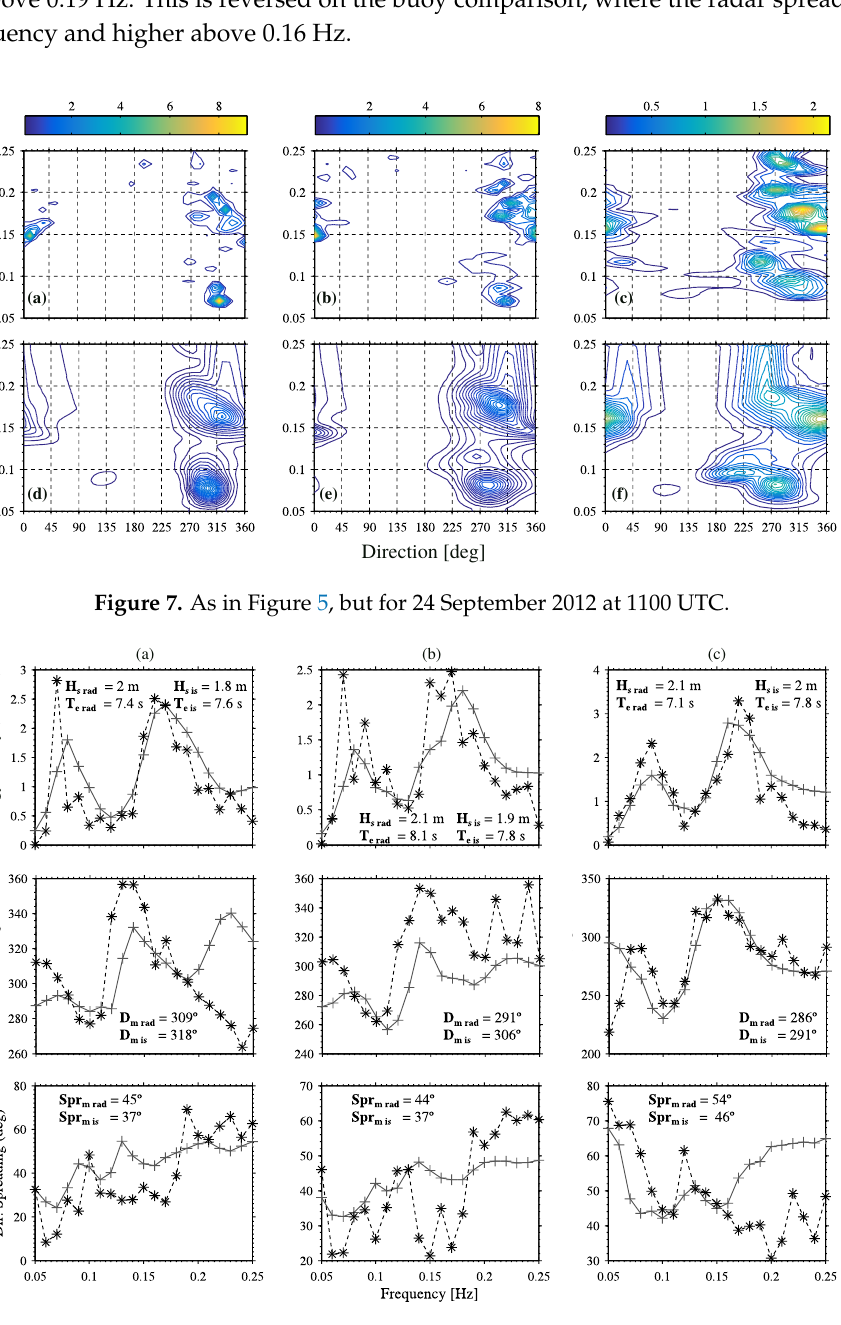
Figure 8. As in Figure 6, but for 24 September 2012 at 1100